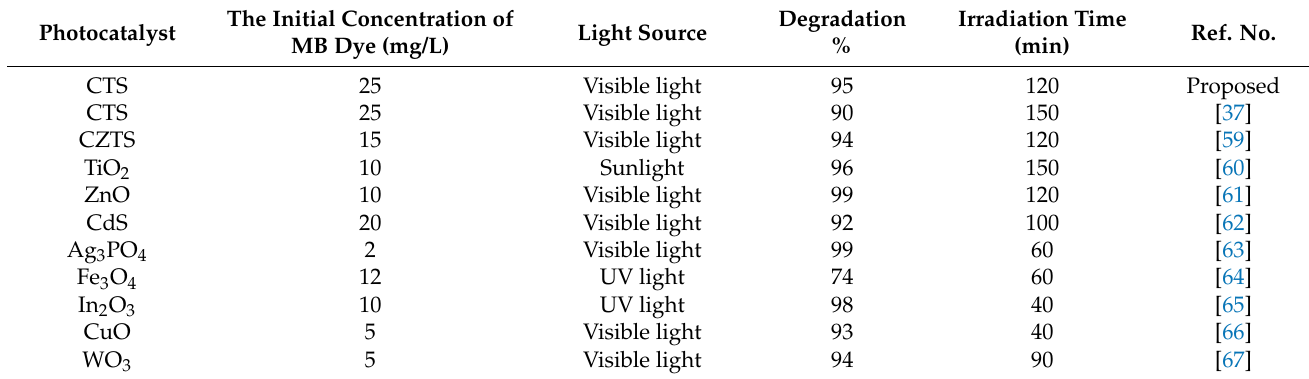
Table 1. Summarizes the different photocatalyst studies for the photocatalytic degradation of the MB